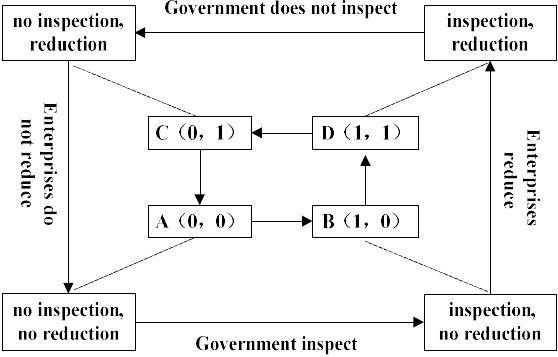
Figure 1. System evolution phase diagram.